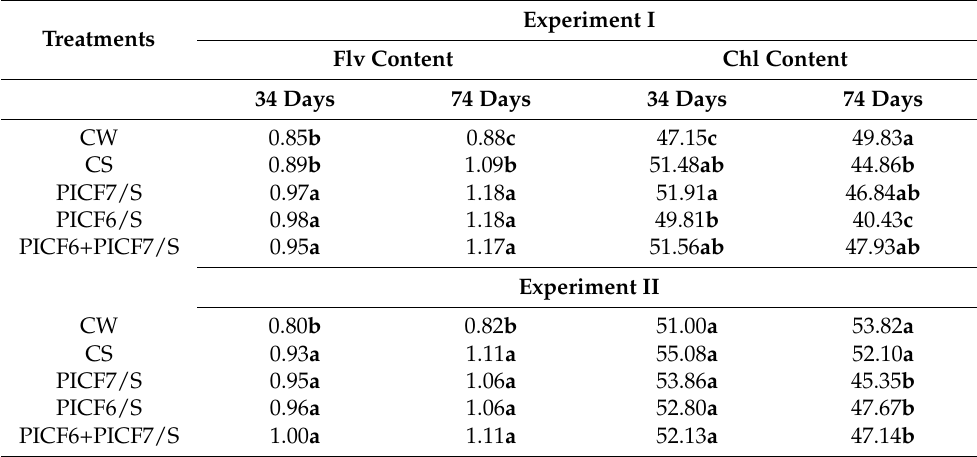
Table 4. Measurement of total flavonoids (Flv) and chlorophyll (Chl) in olive (cv. Picual) leaves subjected to salt stress.